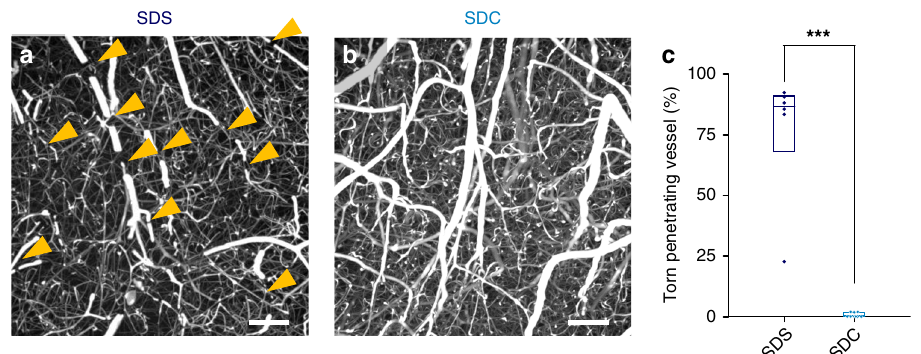
Fig. 3 Breakage of the casted hydrogel is suppressed in SDC-based tissue clearing. a, b Maximum projection of volumetric images of the neocortex. The vascular-casted samples were delipidated using SDS a or SDC b and were immersed in Sca l eCUBIC-2. Some penetrating vessels were severed (arrowheads) in the SDS-treated group, whereas such breakages were rarely observed in the SDC-treated group. Scale bar = 100 μ m. c The percentages of the broken penetrating vessels in the brain treated with SDS and SDC ( n = 6 and 9 brains, respectively; box plots indicate median and 25 − 75% interquartile ranges, *** P = 8.84 × 10 − 7 , t 13 = 8.70, Student ’ s t -test). Source data are provided as a Source Data